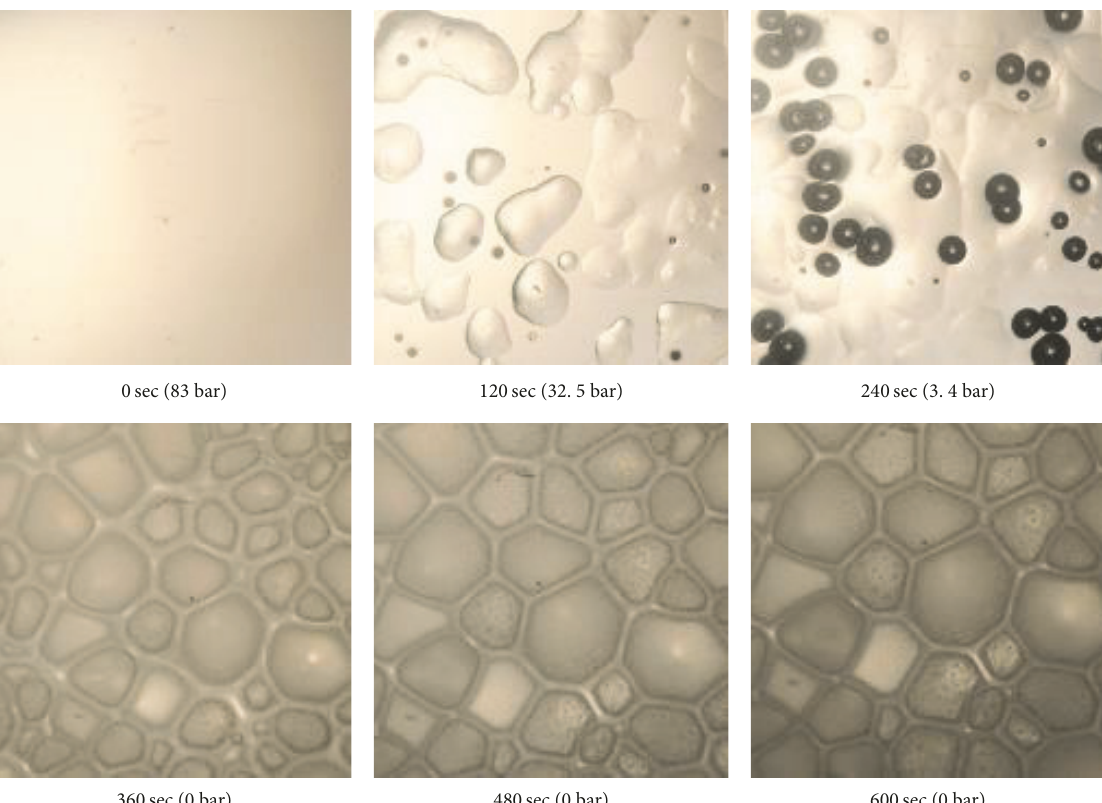
Figure 10: Photographs of a 1mm thick PS sample at various times after the onset of depressurization after holding at 83 bar (in CO 2 ) and 100 ∘ C for 2 hours (scale of images is 6 × 6 mm).